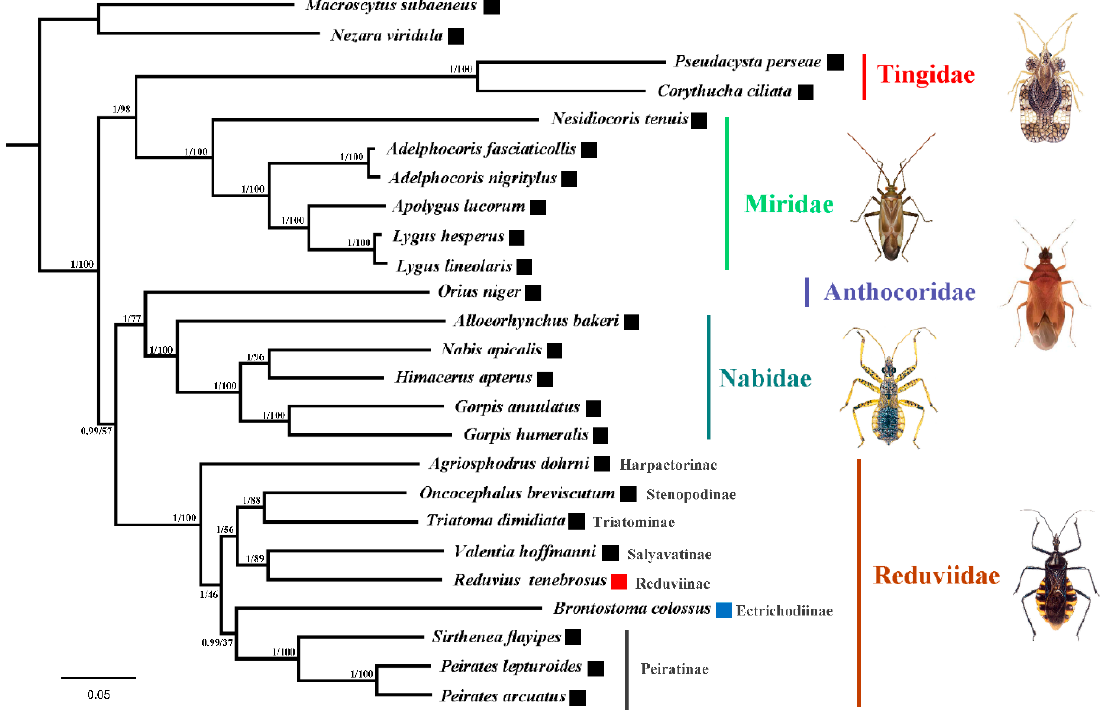
Figure 7. The phylogenetic relationships among the seven reduviid subfamilies and five cimicomorphan families inferred from the mt genome sequences. Numbers close to the branching points are Bayesian posterior probabilities and maximum likelihood (ML) bootstrap support values. The black boxes refer to species without duplicated tRNAs. Red boxes indicate duplicate tRNA derived from the tRNA duplication/anticodon mutation model. Blue boxes represent duplicated tRNA caused by the tandem duplication/random loss model.